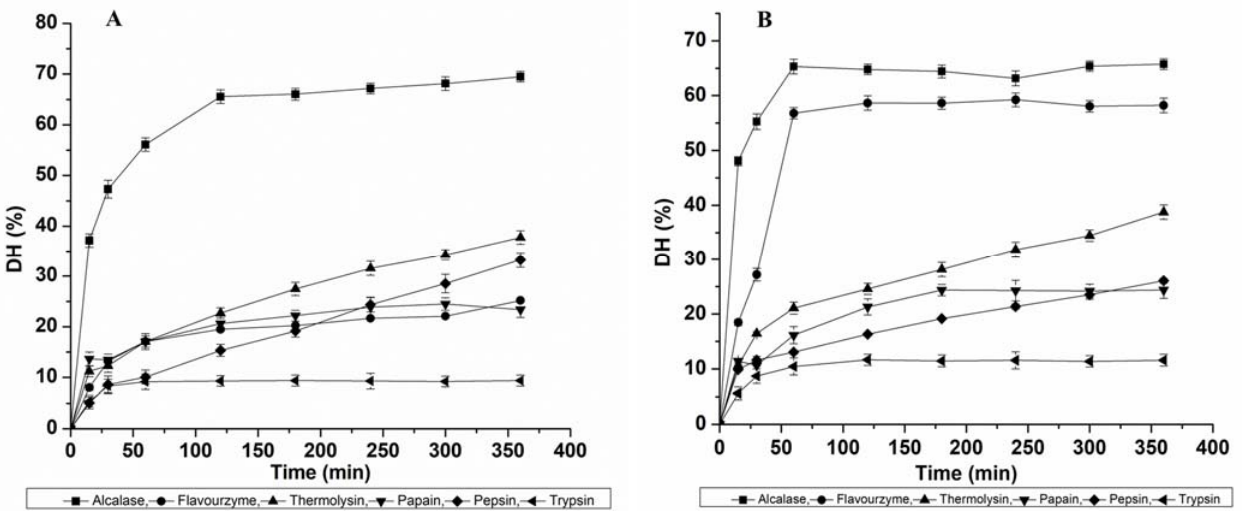
Figure 1. Effect of six proteases (Alcalase, Flavourzyme, Thermolysin, Papain, Pepsin and Trypsin) on the degree of hydrolysis: ( A ) Muga pupae whole protein concentrate (MPPC) and ( B ) Eri pupae whole protein concentrate (EPPC).